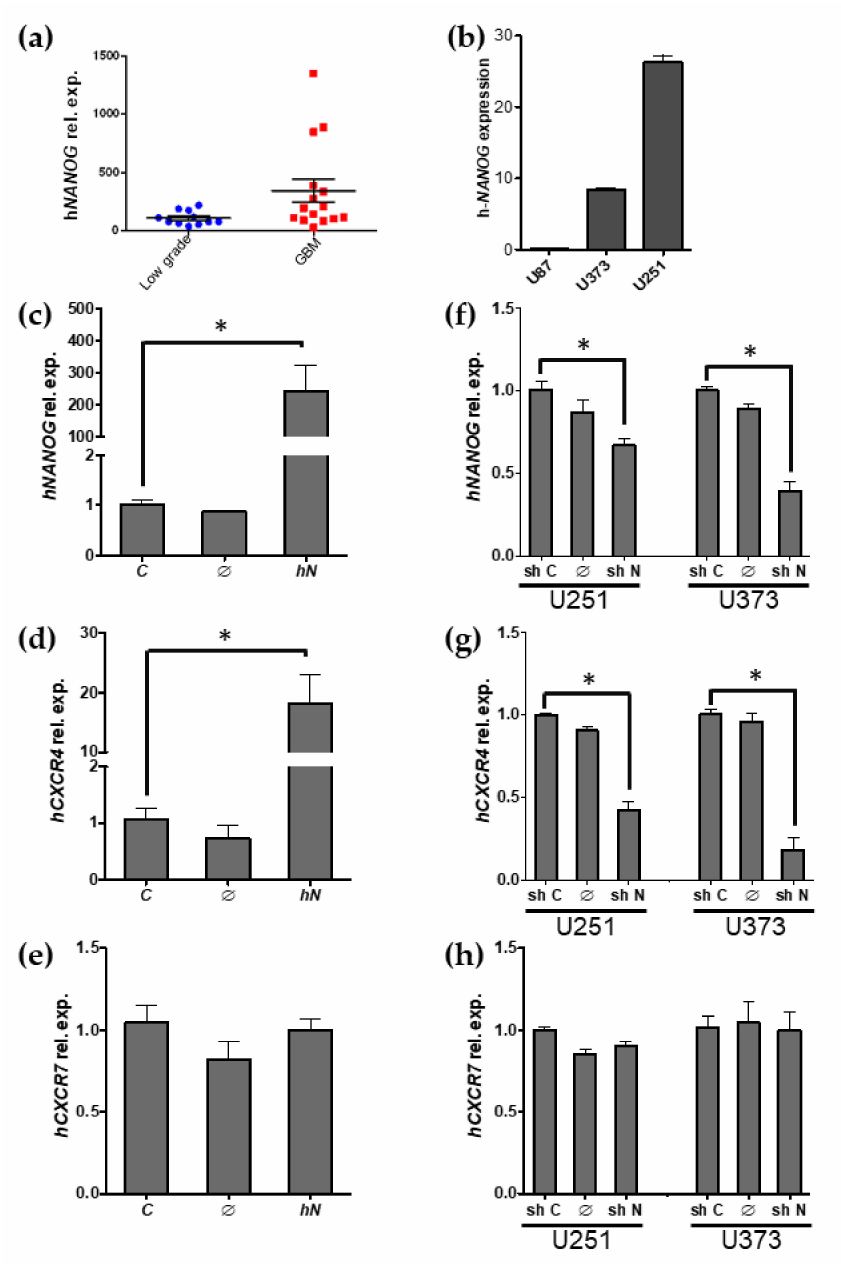
Figure 3. h-NANOG regulates h-CXCR4 expression but not h-CXCR7 expression in human glioblastoma-astrocytoma cell lines. Bar graphs showing relative gene expression. ( a ) h-NANOG expression in brain tumors from human patients, divided into low grade tumors or glioblastomas (GBM). ( b ) h-NANOG expression in the three glioblastoma cell lines used in this study. ( c – e ) Gene relative expressions of h-NANOG ( c ), h-CXCR4 ( d ) and h-CXCR7 ( e ) after h-NANOG transfection of U-87 cells. ( f , g ) Gene relative expressions of h-NANOG ( f ), h-CXCR4 ( g ) and h-CXCR7 ( h ) after h-NANOG transduction of U-251 and U-373 cells. Abbreviations: hN, h-NANOG; C, control; shN, shRNA-hNANOG; shC, shRNA-control. * corresponds to p <